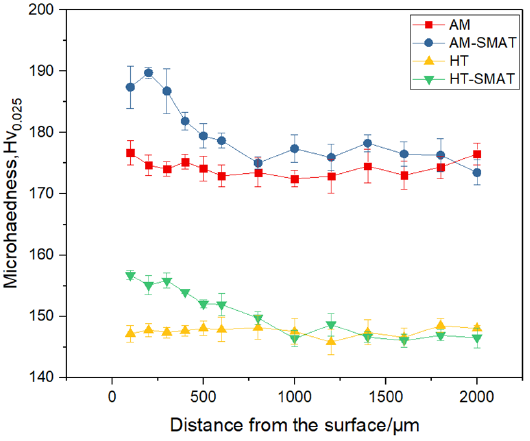
Figure 2. In-depth variations of microhardness for samples prepared with different processes. As for the heat-treated samples (HT and HT-SMAT), the results exhibit a similar trend, but with significantly lower microhardness values for the HT condition. In the center of the heat-treated samples (see the green and yellow curves), the microhardness is around 147 HV 0.025 . Due to the SMAT effect, the microhardness of HT-SMAT is increased to 157 HV 0.025 at the surface. It should be noticed that the hardness decrease rate shown by the green curve (HT-SMAT) is slightly lower than that of the blue curve (AM-SMAT). This seems to imply that the gradient feature obtained by HT-SMAT is less pronounced than that obtained by